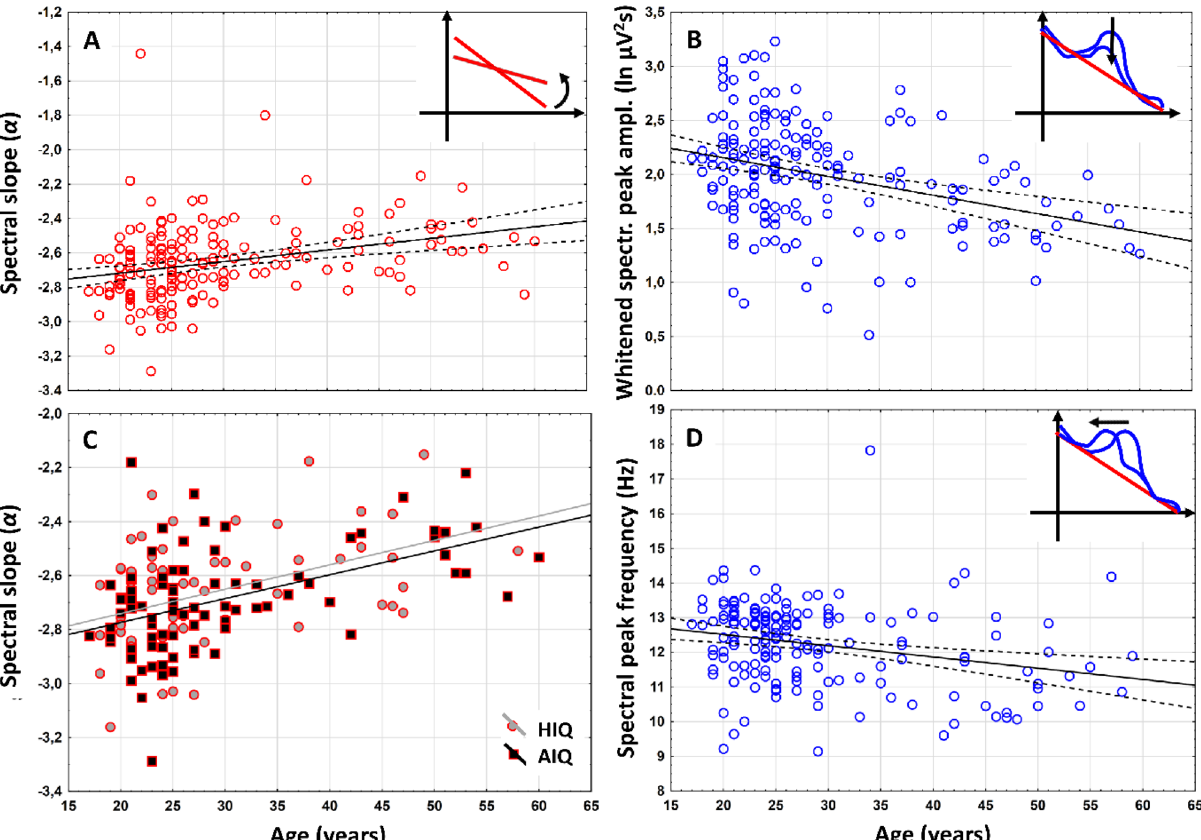
Figure 3. Representative scatterplots of the correlations between age and measures of the NREM sleep EEG spectra at the left prefrontal region (F3). ( A ) Correlation of age with the spectral exponent ( α ) indicating the flattening of the spectral slope in the aged subjects. ( B ) Correlations of age with the whitened maximal spectral peak amplitude in the sleep spindle frequency range ( P Peak (f maxPeak ). Note the decrease in whitened spectral peak amplitude in the aged. ( C ) Correlation of age with the NREM sleep EEG spectral exponent ( α ) as categorized by intelligence ( HIQ high intelligence quotient, AIQ average intelligence quotient). Note the lack of an IQ effect. ( D ) Correlation of age with NREM sleep EEG maximal spectral peak frequency ( f maxPeak ) in the spindle range. Note the age-dependent decline in frequency. Color codes are consistent with Fig. 1: red—spectral slopes, blue— spectral